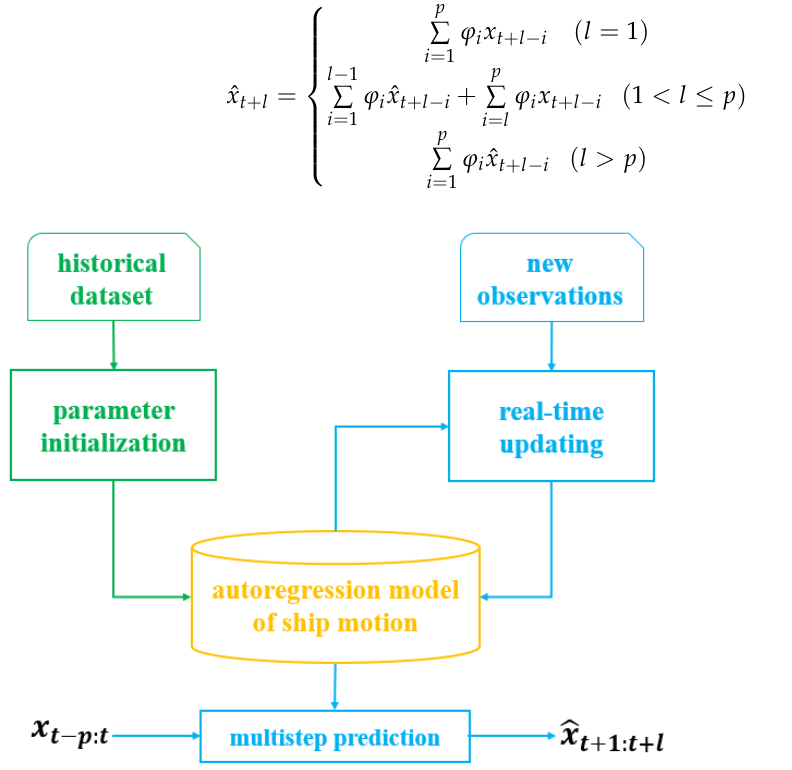
Figure 1. Parameter identification and multistep prediction based on the autoregression model of ship